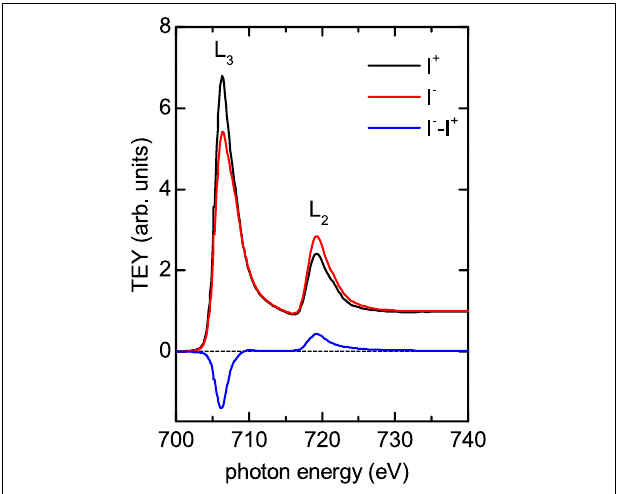
FIGURE 2 | Showing a sample intensity and difference XMCD spectrum at the Fe edge. The large MCD signal from the densely packed clusters enables an accurate determination of the m l / m s ratio. The data has been normalized to the post-edge signal.